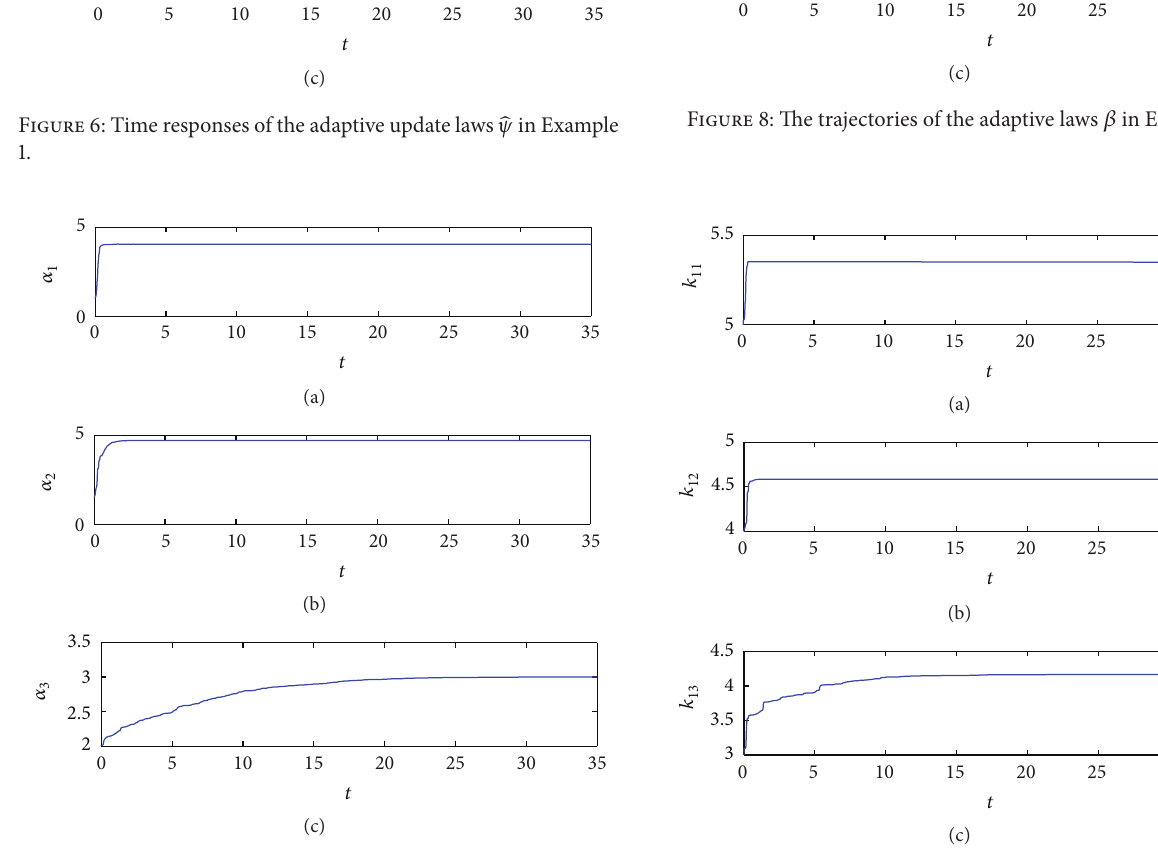
Figure 9: The trajectories of the adaptive laws 𝑘 11 , 𝑘 12 , and 𝑘 13 in Example